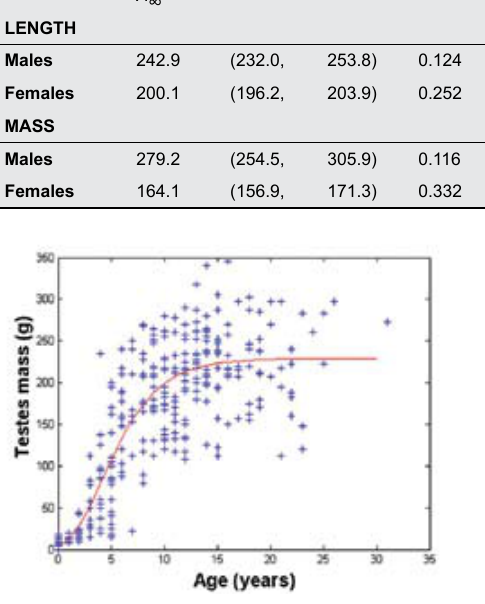
Fig. 4. Mean mass of male grey seal (Halichoerus grypus) testes in relation to age, according to the Gompertz growth length of 78 cm and weighed 10.3 kg. The larg- est male foetus had a standard length of 79 cm and weighed 12.8 kg male. Both foetuses were obtained from female grey seals in August 1992. sites were a 88 cm and 10 kg female and a 83 cm and 12 kg male, collected in November